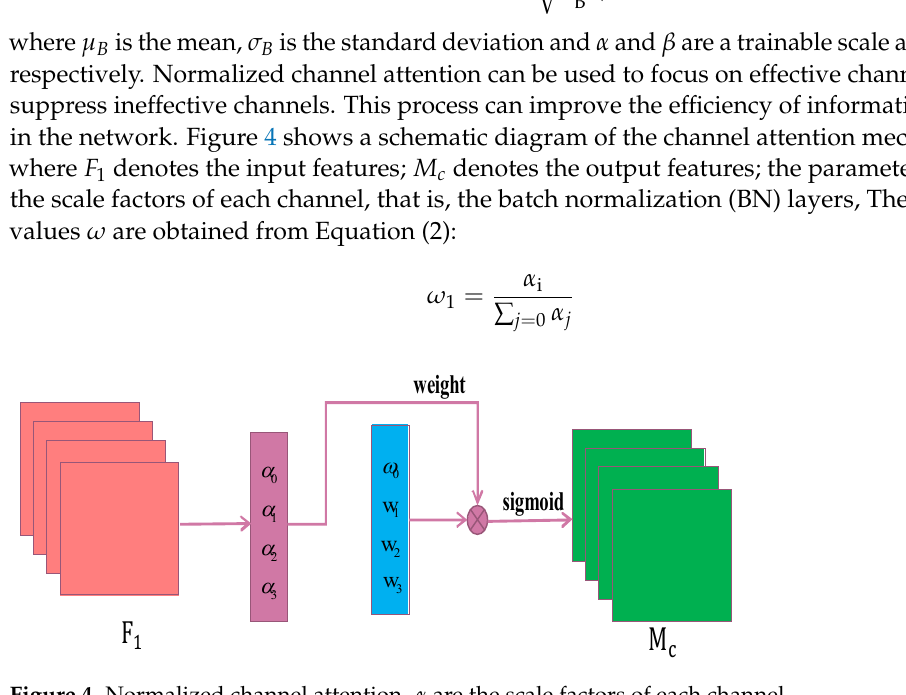
Figure 4. Normalized channel attention. α are the scale factors of each channel.